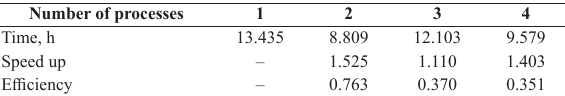
Table 3. Cherenkov-cluster implementation of ODETTA